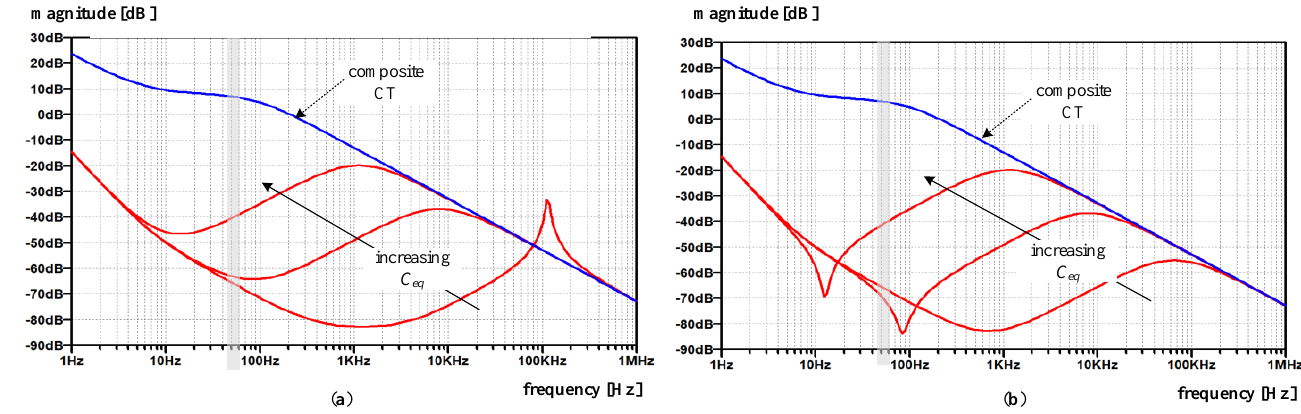
Figure 10. Disturbance rejection capability H dist composite CT (blue line) vs H dist EECT (red lines) for varying C eq = {5 pF, 1 nF, 50 nF }: ( a ) original amplifier; ( b ) modified amplifier.